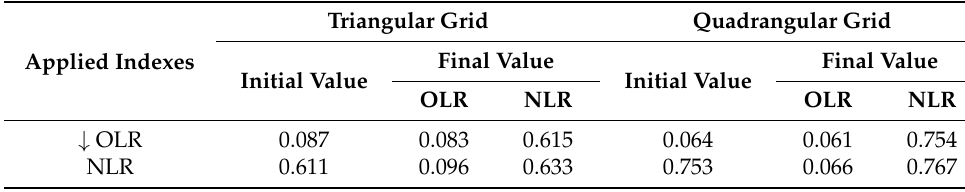
Table 1. The final results on comparing the length ratios.